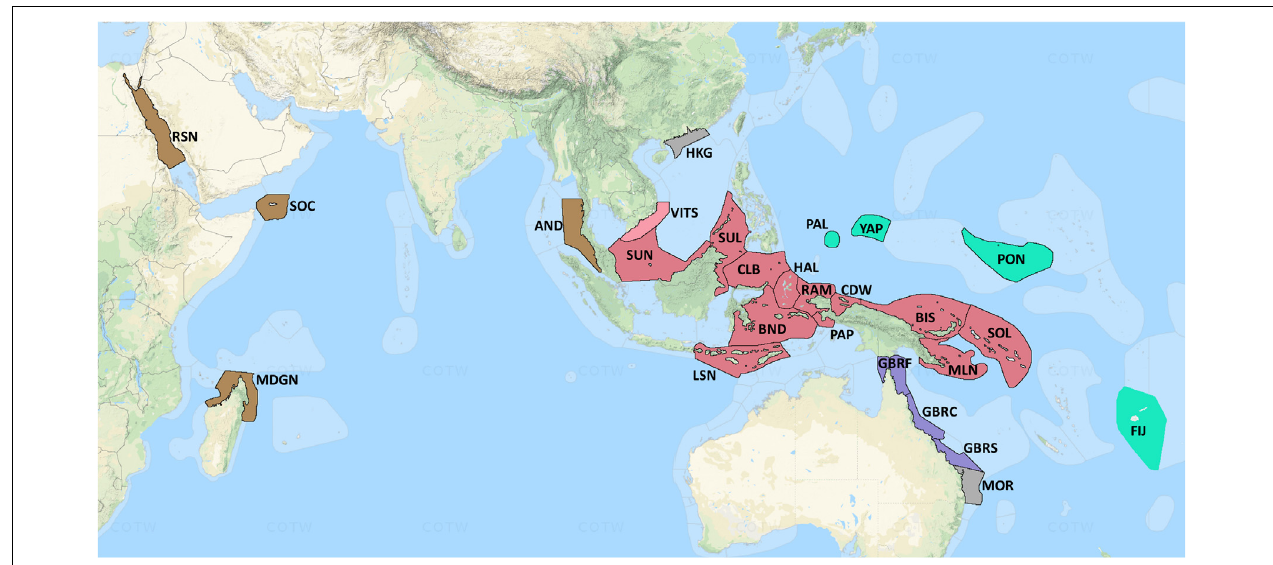
FIGURE 1 | Map of location of 26 coral ecoregions across the IWP region. ER names are provided in Table 1 . Map courtesy of COTW (Veron et al., 2020). Color shadings reflect broad biogeographic affinities, and for Moreton Bay and Hong Kong ERs, environmental marginality. These colors and name codes are used to aid interpretation in subsequent